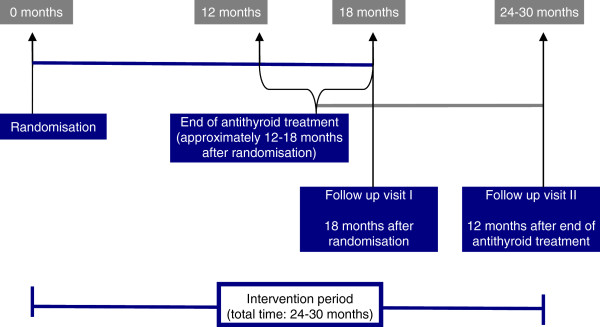
Duration of the intervention.